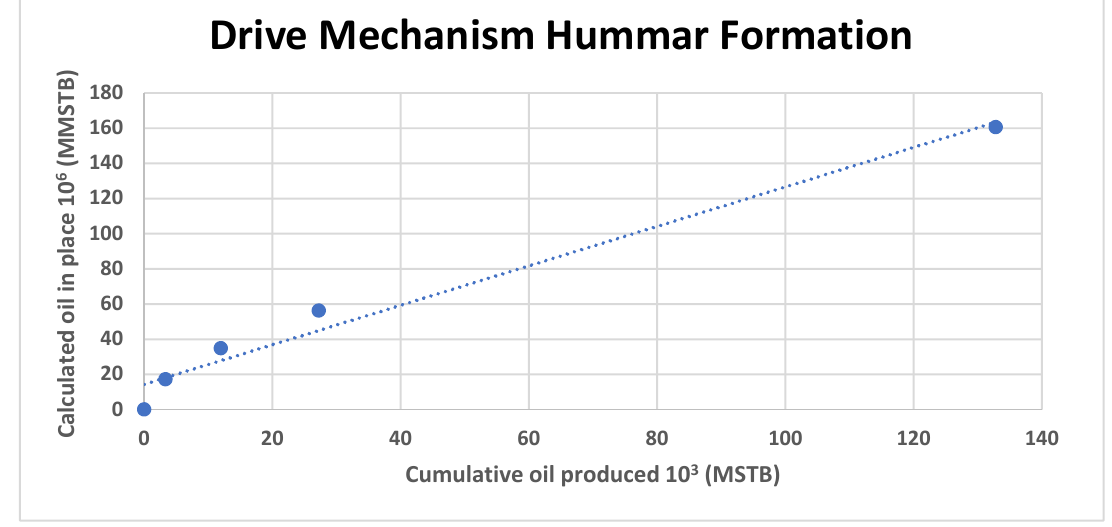
Figure 3. Calculated oil in place vs. cumulative oil production in the Hummar formation.